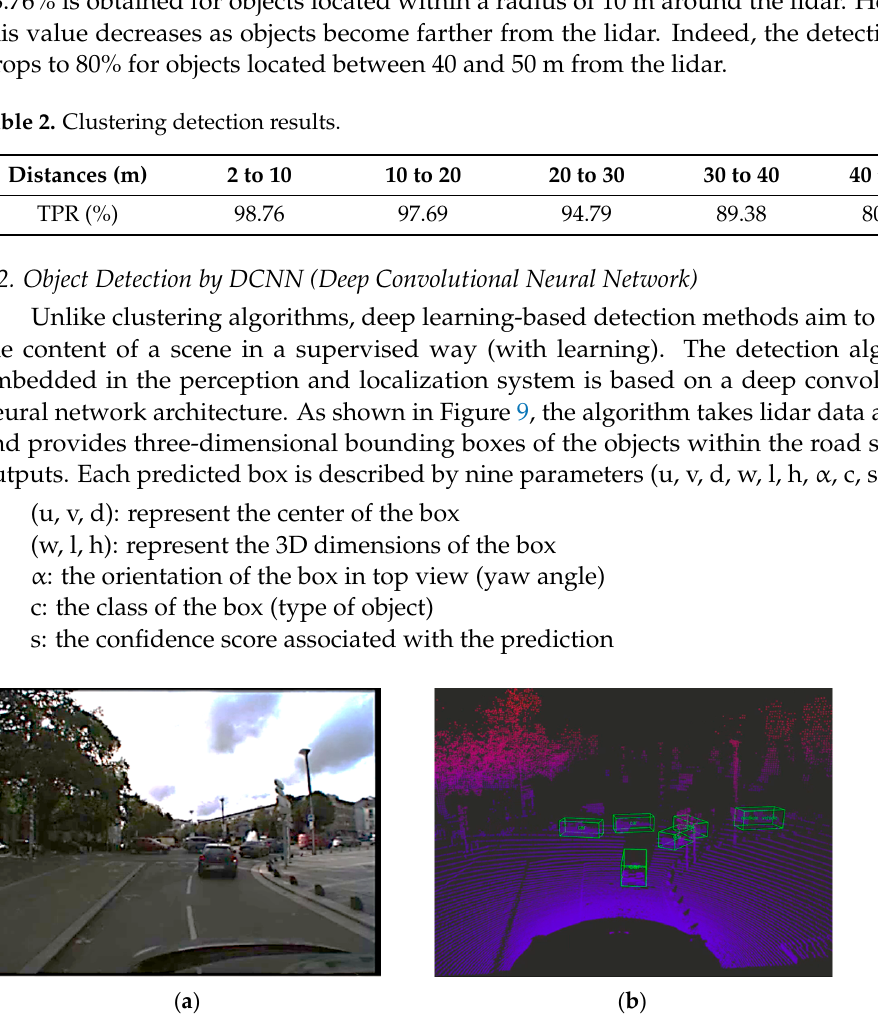
Table 2. Clustering detection results.